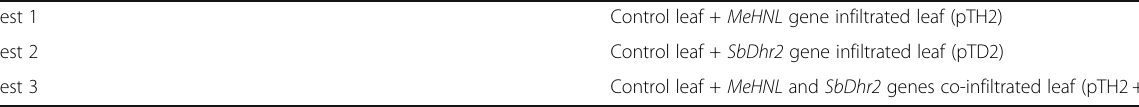
Table 3 Three settling preference choice tests Test